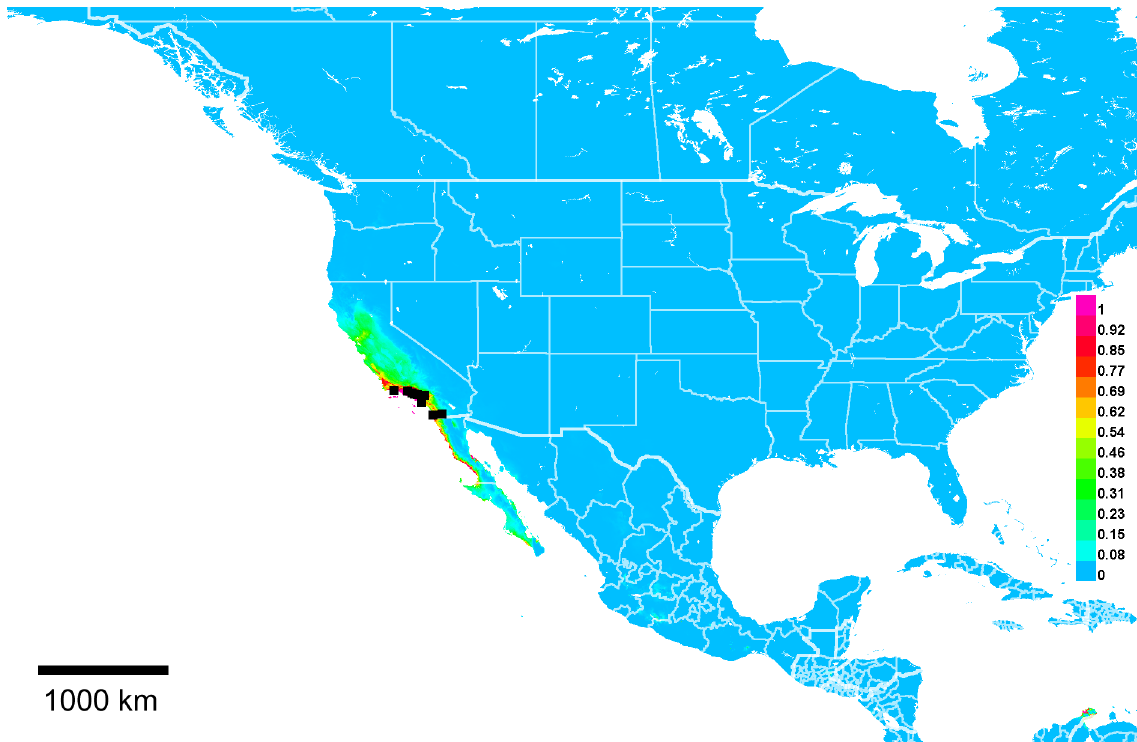
Fig. 5. Georeferenced collection records of Lasioglossum ( D .) angelicum sp. nov. (black squares) and predicted distribution by maximum entropy ecological niche modelling in Maxent (colour shading). Warmer colours indicate higher cloglog probability of